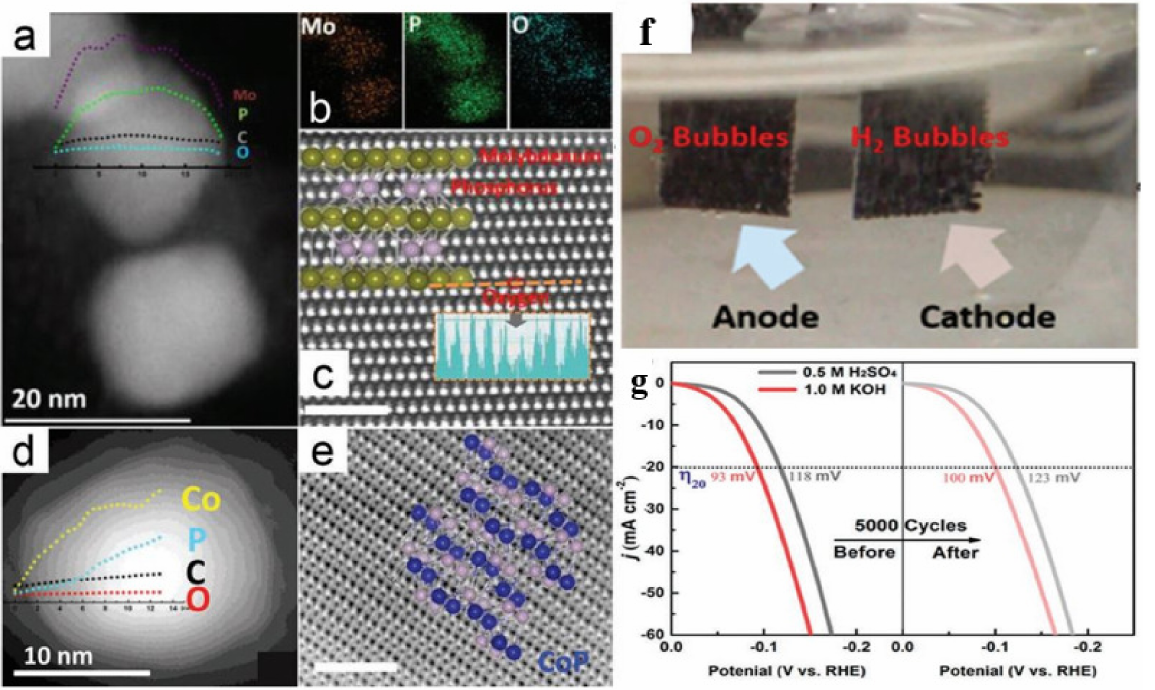
Figure 13. ( a ) STEM image of MoP nanoparticles. Inset: intensities for different elements. ( b ) Large area STEM-EDS mapping to Figure 13a. ( c ) HAADF-STEM image of MoP with the corresponding crystal structure superimposed. The intensity profile along orange dashed line directly shows the presence of O atoms. ( d ) The STEM image of CoP. Inset: the intensities of the elements present in particles. ( e ) HAADF-STEM image of CoP with the crystal structure superimposed. Scan bars, 1 nm. ( f ) Optical photograph showing the generation of bubbles on the MoP- and CoP-based electrodes. ( g ) Polarization curves of MoP measured both in 0.5 M H 2 SO 4 and 1 M KOH (left) and curves after 5000 potential sweeps at 20 mV · s − 1 (right), without iR-drop corrections. (Reprinted with permission from reference [153]. Copyright 2016, American Chemical